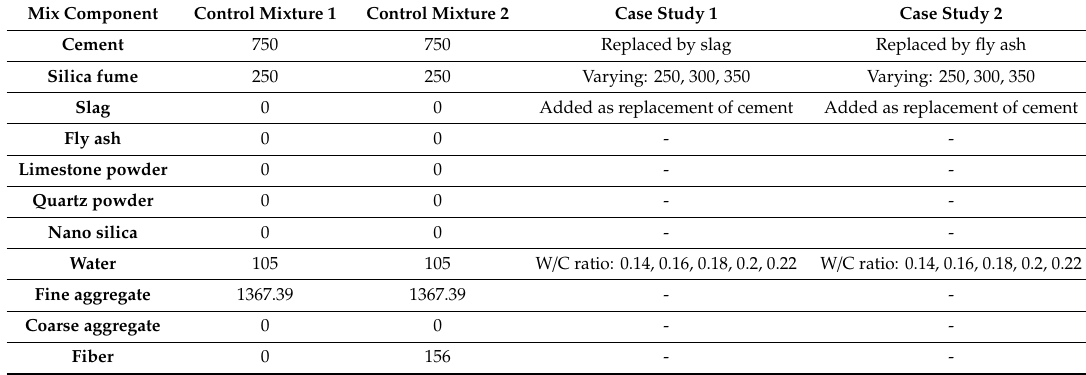
Table 6. Control mixture designs and case studies for parametric